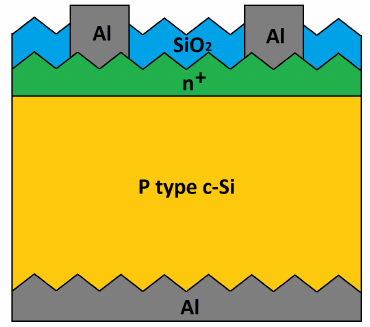
Figure 6. Fabricated solar cell structure.